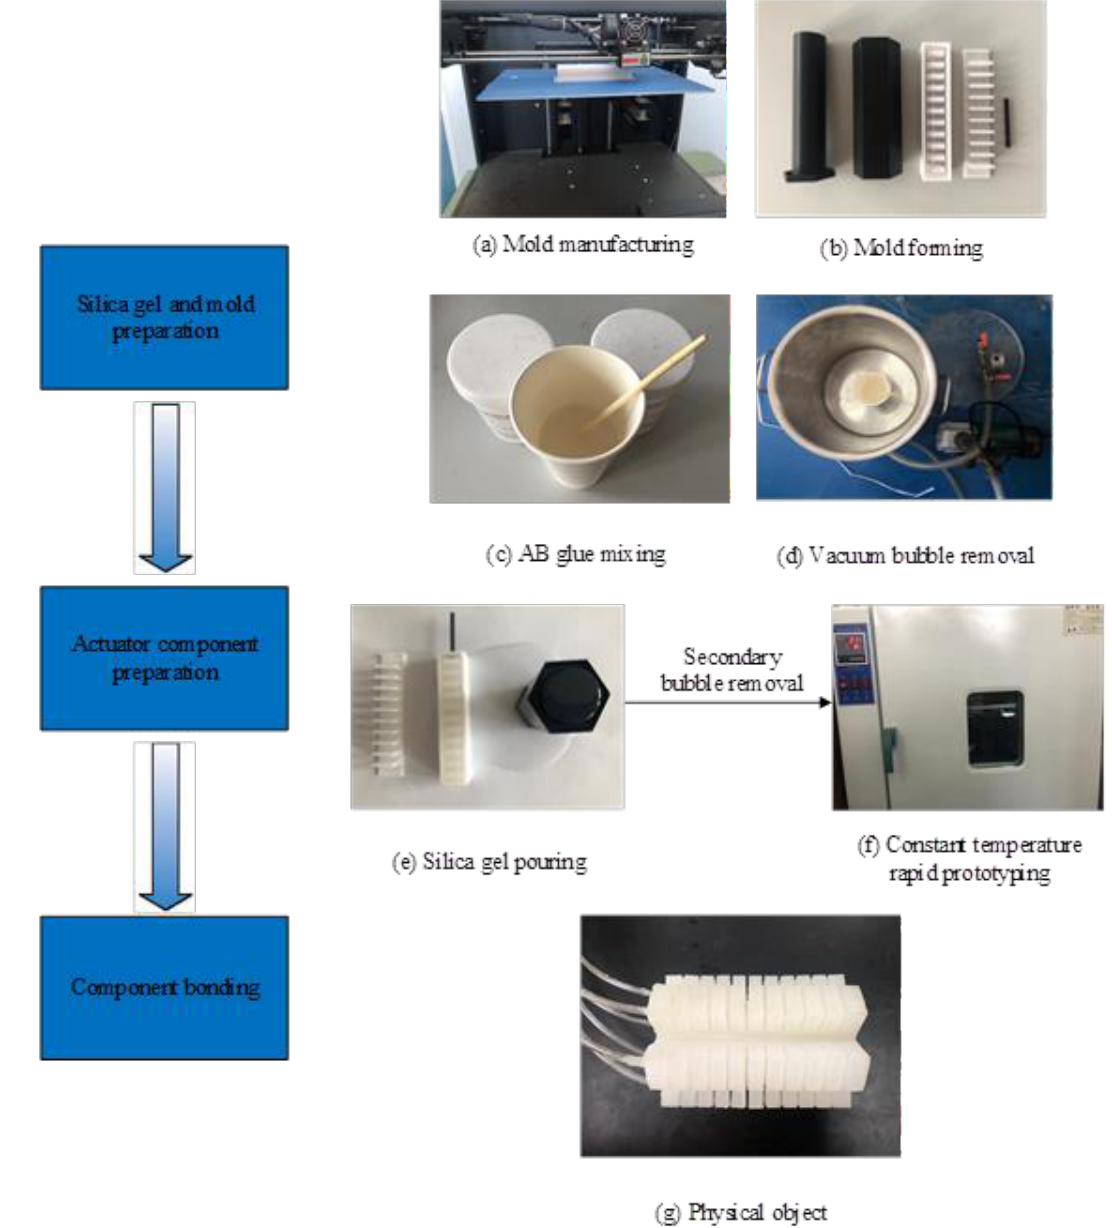
Figure 9. Physical preparation process of the hexagonal prism soft-bodied bionic actuator.